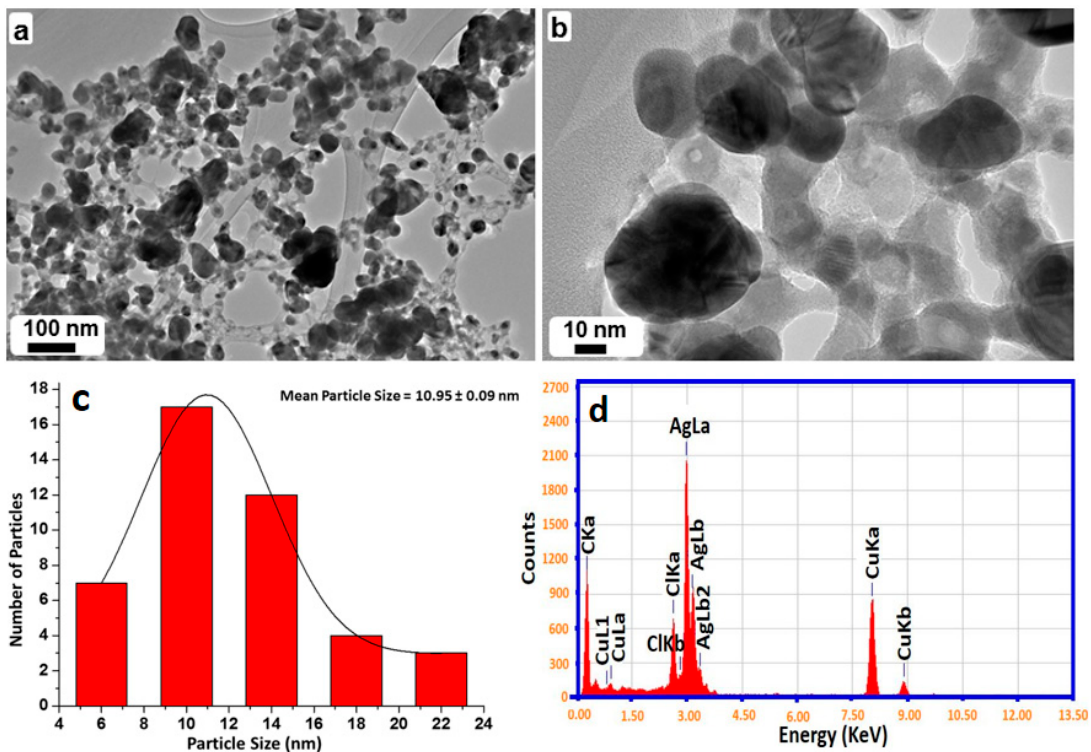
Figure 6. Transmission electron microscopy (TEM) and HRTEM (high-resolution) images of the Ag-NPs ( a ) overview; ( b , c ) Particle size distribution graph of Ag nanoparticles; ( d ) energy-dispersive X-ray spectroscopy (EDX) of Ag-NPs.